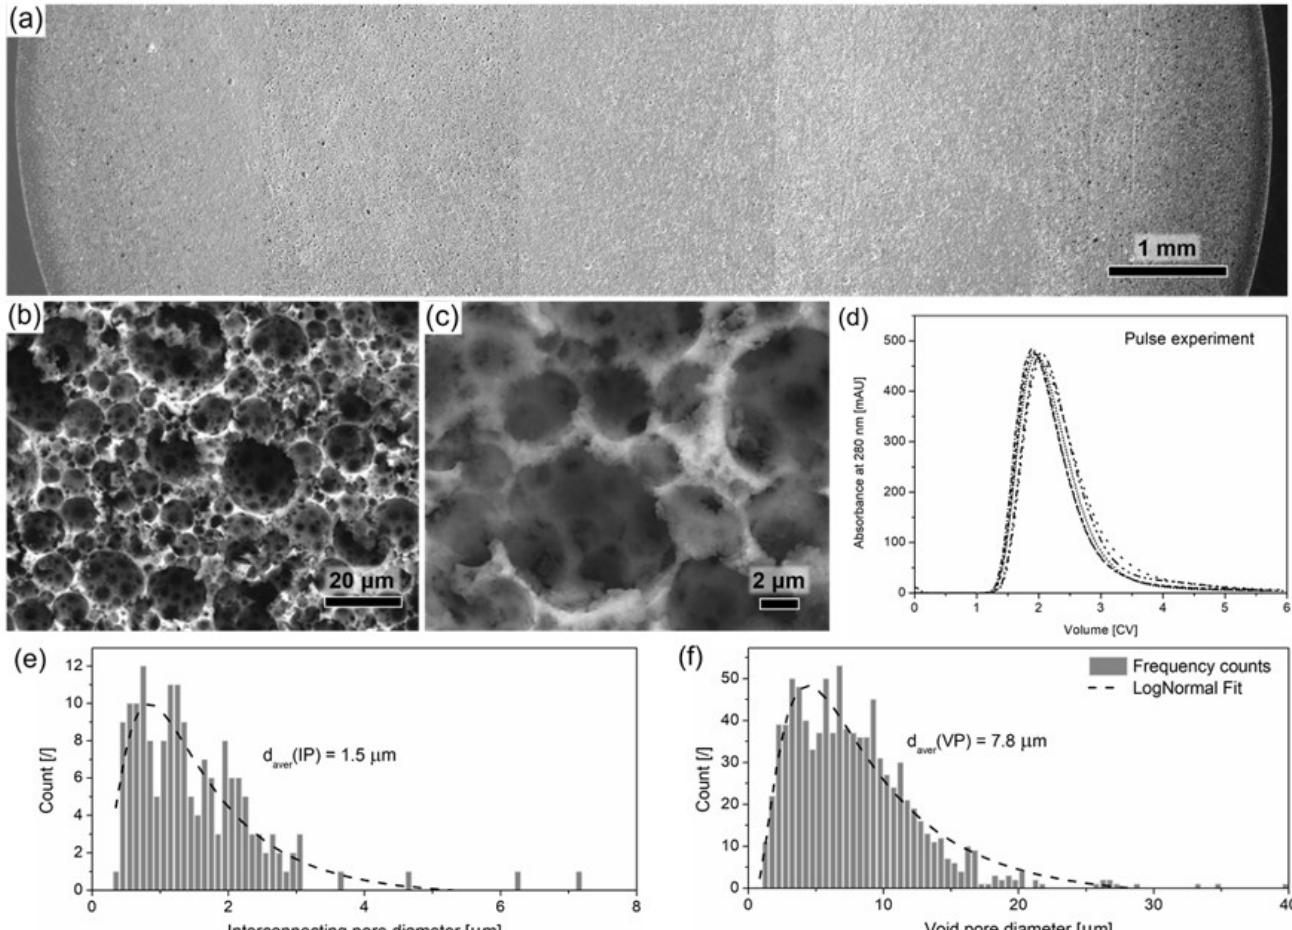
Figure 1. SEM images of the polyHIPE cross-section ( a ) and its microstructure at higher magnifications ( b , c ). Corresponding pulse experiment results performed at different flow rates are shown in ( d ). Bottom are presented pore size distributions, frequency counts, and average pore size for interconnecting ( e ) and void ( f )